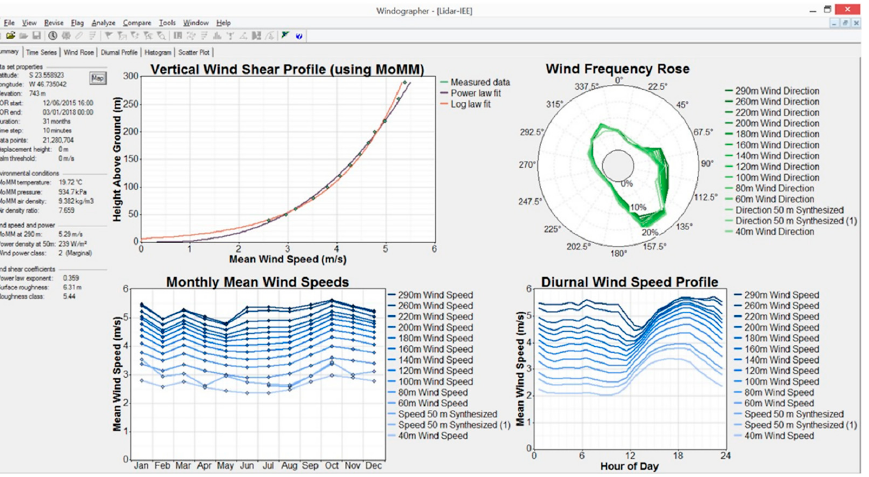
Figure 8. Software recordings measurements screen. Source: Our elaboration using Windographer ® .